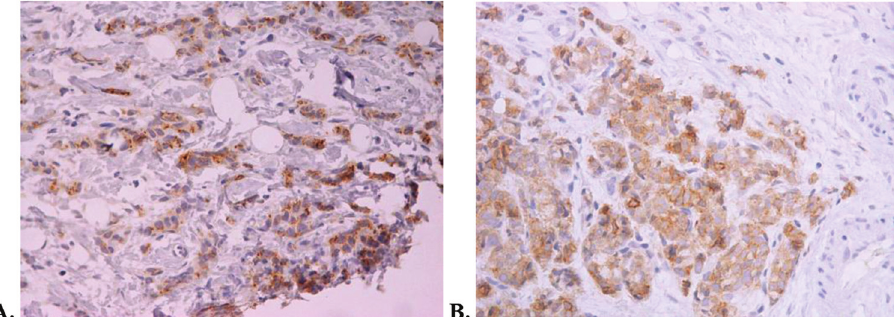
Figure 2 - Lewis Yantigen expression of the patient with stable disease for more than 2 years who was administered hu3S193 according to immunohistochemistry. A. Predominant membrane Lewis Y staining (cid:1) 200. B. Membrane and cytoplasm Lewis Y staining (cid:1)